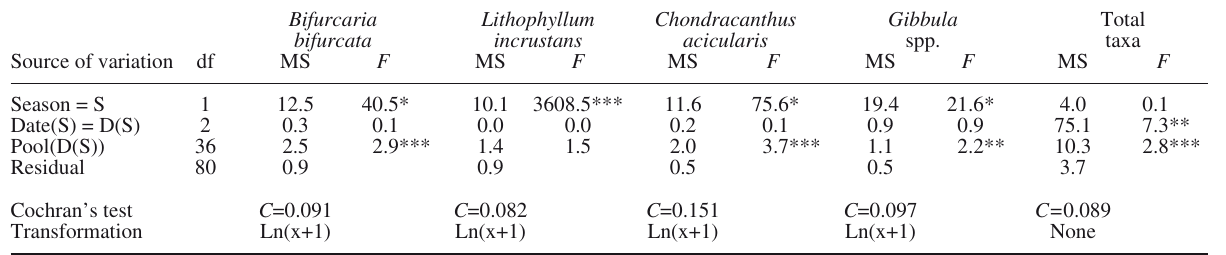
Table 4. – Summary of ANOVAs for individual taxa and the total number of taxa from rock pool assemblages. * p<0.05; ** p<0.01, *** p < 0.001.